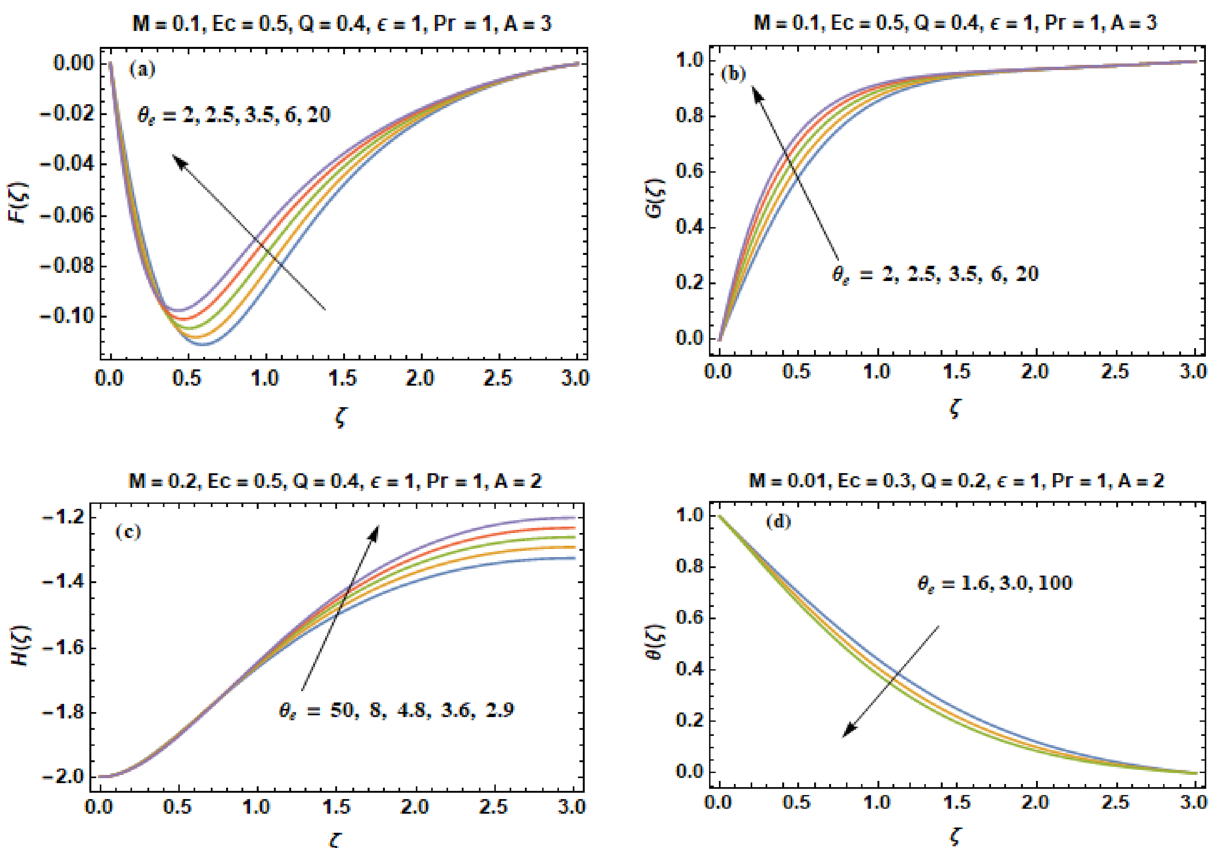
Figure 5. ( a–d ) Components of velocity (F, G, H) & temperature profile (θ) versus variable viscosity parameter θ e >